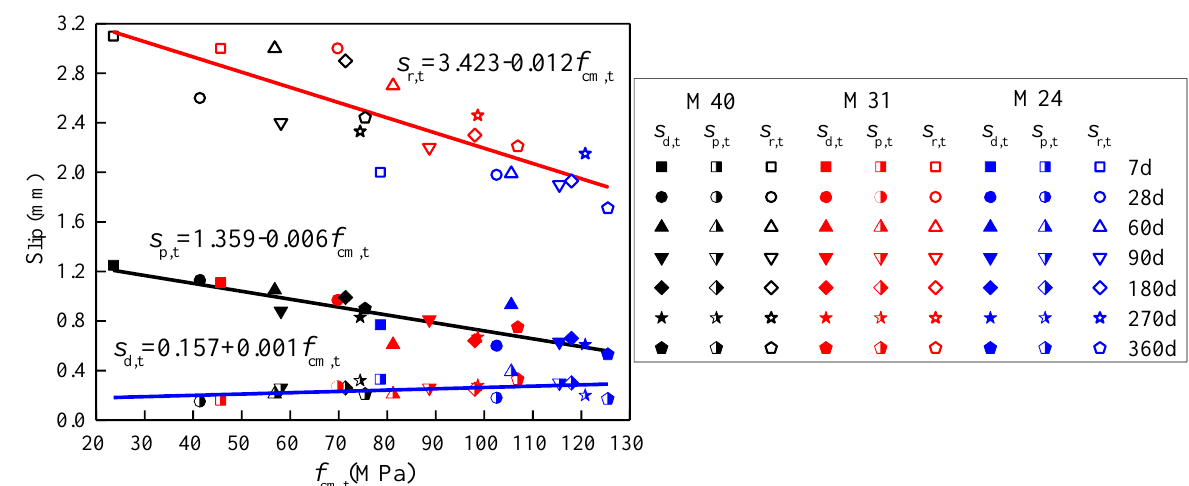
Figure 13. The slips s p,t and s r,t decrease with the increase in mortar compressive strength with Adj-R 2 of 0.764 and 0.657, respectively. No regularity was observed in the slip s d,t .